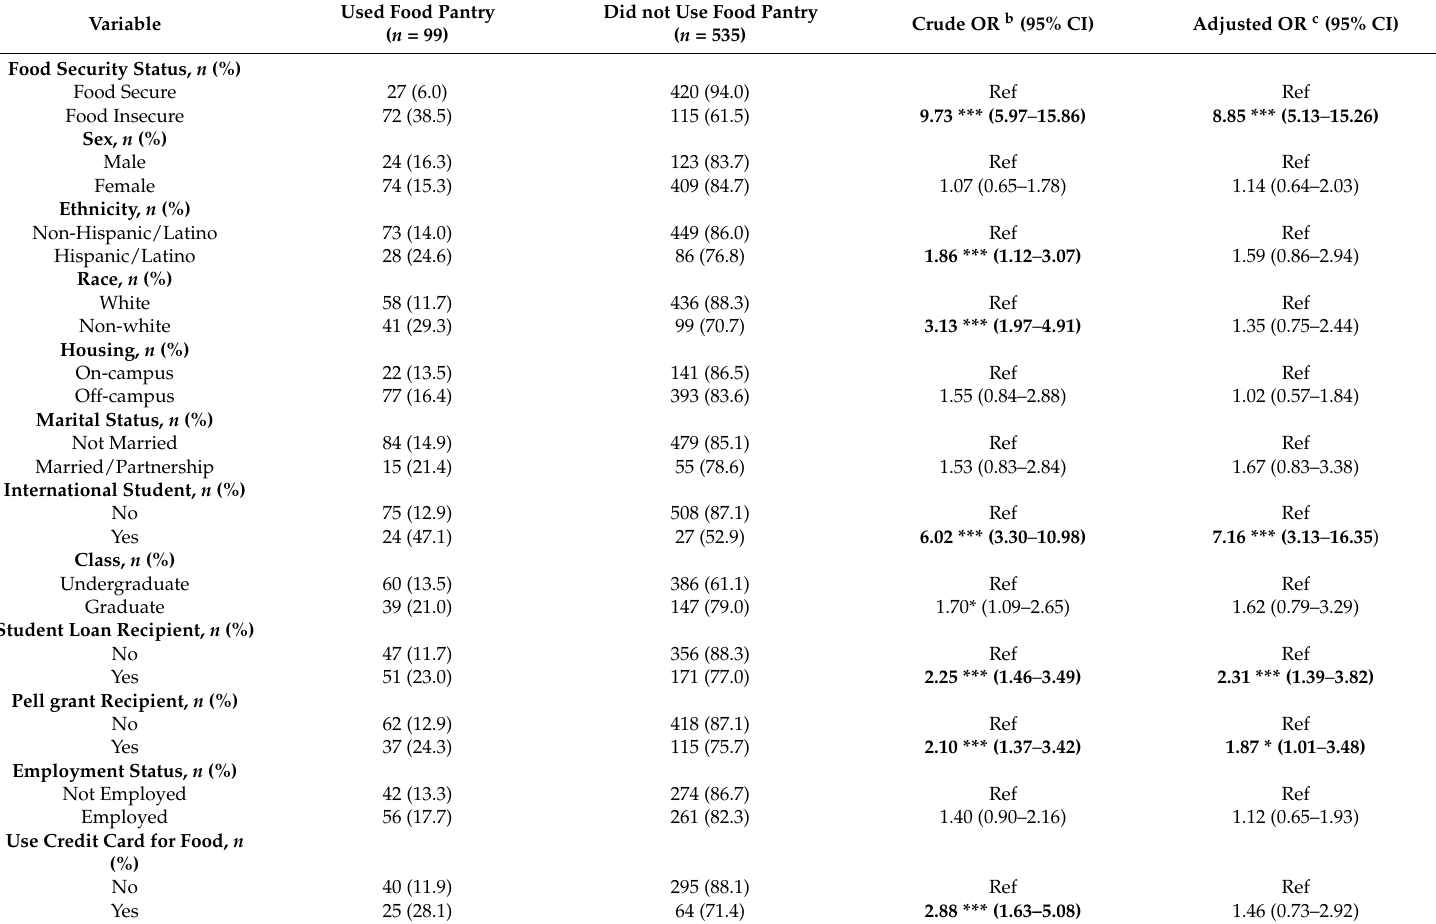
Table 3. Predictors of using the campus food pantry by college students in the United States, 2017 a